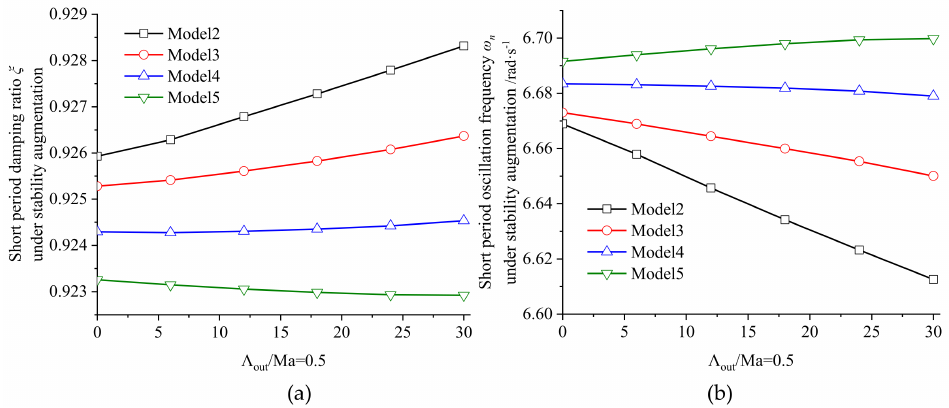
Figure 14. The short-period damping ratio ξ and oscillation frequency ω n of the UAV system after stability augmentation adjustment when Ma = 0.5. ( a ) Damping ratio ξ , ( b ) oscillation frequency ω n